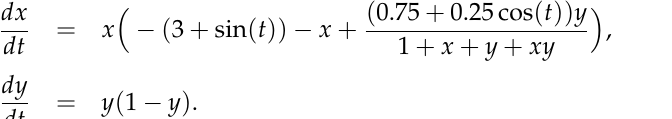
Figure 2. Stability of positive equilibrium (0.28,1); here we take a 1 = 1 initial conditions ( x ( 0 ) , y ( 0 )) = ( 0.04,2 ) , ( 0.5,0.2 ) , ( 0.5,0.02 ) , ( 0.5,0.4 ) , ( 0.2,2 ) , and ( 0.01,2 )